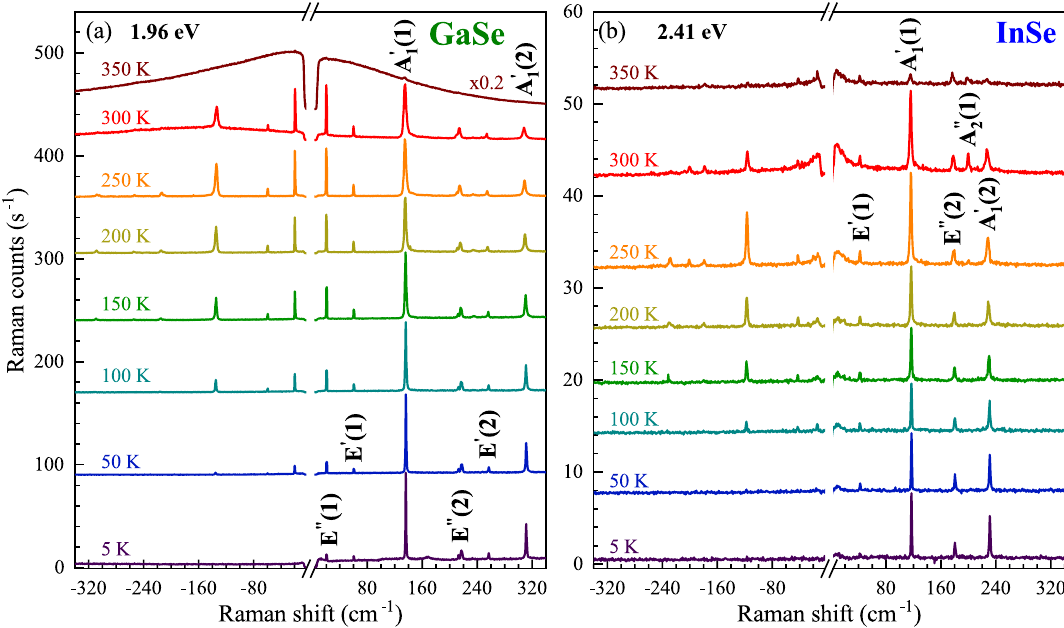
Figure 2. Raman scattering spectra of the studied ( a ) GaSe and ( b ) InSe measured at selected temperatures under resonant excitation regimes. The spectra are shifted for than the InSe optical band gap. However, the 2.41 eV excitation stays in the vicinity of the so-called B transition at Ŵ point of the BZ in InSe of energy around 2.4 eV 6 . It suggests that resonant conditions of Raman scattering can be achieved under excitation of 1.96 eV for GaSe and 2.41 eV for InSe due to the energy proximity of the optical band gap and the B transition, respectively. Temperature influence on resonant Raman scattering. In order to investigate the aforementioned resonant conditions in Raman scattering, we carried out RS experiments in a broad range of temperatures from about 5 to 350 K. Figure 2(a) and (b) display the RS spectra of the GaSe and InSe consisting of both the Stokes and anti-Stokes scatterings measured at selected values of temperature under excitations of 1.96 eV and 2.41 eV, respectively. As can be appreciated in the Figure, only the Stokes-related signal is observed at the lowest tempera- tures. It is due to the nature of Stokes and anti-Stokes processes, which are related correspondingly to emission and absorption of phonons. As phonons are bosons, their population is described by the Bose-Einstein statistics. At absolute zero temperature, a crystal lattice lies in its ground state and contains no phonons. As a result, an increase of sample temperature leads to increased number of available phonons, which is accompanied by an increase of the number of phonon absorption processes giving rise to the anti-Stokes signal at elevated tempera- tures. This kind of evolution is demonstrated in Fig. 2(a) and (b). Moreover, the influence of increasing tempera- ture on a given RS peak is revealed by a red shift of energy, a broadening of linewidth, and a variation of intensity. ′ These three processes can be clearly noted for the A 1 (1) modes apparent in the RS spectra of the GaSe and InSe crystals. In different materials, including S-TMDs 29,34–36 , one finds that both the energy and the linewidth of phonon mode vary with temperature. This temperature dependence was attributed to the anharmonic terms in the vibrational potential energy 37 . As we investigate the temperature effect on excitation conditions of RS, we focus our attention on its influence on phonon-modes intensities. While in almost the whole range of the used temperature to about 300 K, there is no significant change of peaks intensities, a strong quenching of the RS signal for all the observed lines in GaSe and InSe is apparent at the highest temperature of 350 K. This kind of behaviour can be ascribed to the variation of the excitation conditions of RS. As we measured RS spectra with the fixed laser energy for a given material, the temperature affects the band structure of the studied GaSe and InSe resulting in the change of the relative energy separation between laser energy and the optical band-gap energy for GaSe or B-transition energy for InSe. Interestingly, the vanishing of phonon modes at T =350 K for GaSe is accompanied with the emergence of the broad emission covering the whole range of the detected ener- gies, which can be ascribed to the emission in the vicinity of the optical band gap of GaSe. For the InSe, a similar quenching of phonon modes at T =350 K is followed by the emission extending from laser liner in both Stokes and anti-Stokes scatterings, which may be attributed to the resonant excitation of the B transition. To investigate in more detail the temperature effect on the phonon-modes intensities, we fitted the observed phonon modes with Gaussian functions. The obtained intensity evolutions of the RS peaks under both excitation energies (1.96 eV and 2.41 eV) as a function of temperature are presented in Figs. 3 and 4. First, we can focus on the temperature evolutions of the phonon modes shown in Fig. 3. It is observed that their intensity dependencies for both materials are very similar, if the results are compared diagonally, i.e. Fig. 3(a) and (c); Fig. 3(b) and (c). For the former case, i.e. Fig. 3(a) and (c), a small temperature effect on the modes intensities is apparent up to